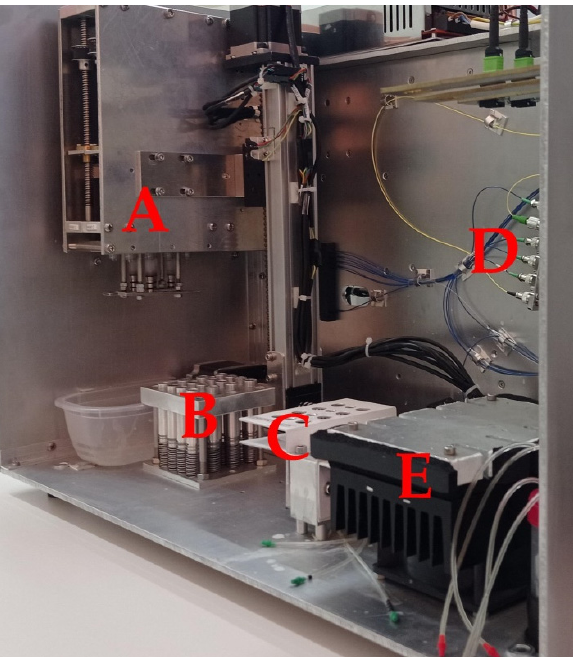
Figure 2. The novel POC system: ( A ) syringe system, ( B ) pipette tip holder, ( C ) buffer/sample holder, ( D ) optic fibers and optical splitter, ( E ) temperature control module.